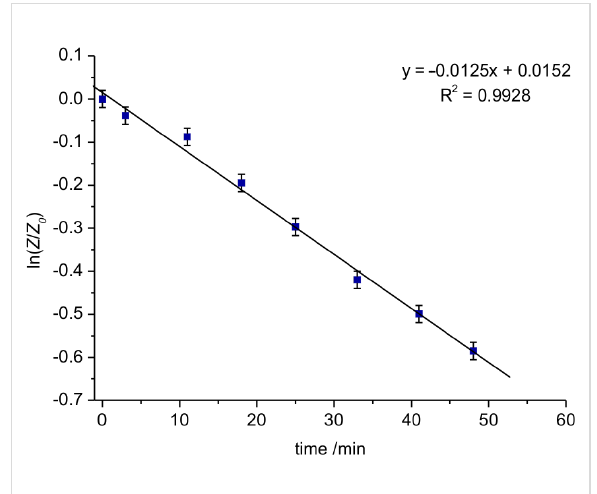
Figure 1: Equilibration of the Z -rotamer of 4 at 293 K.